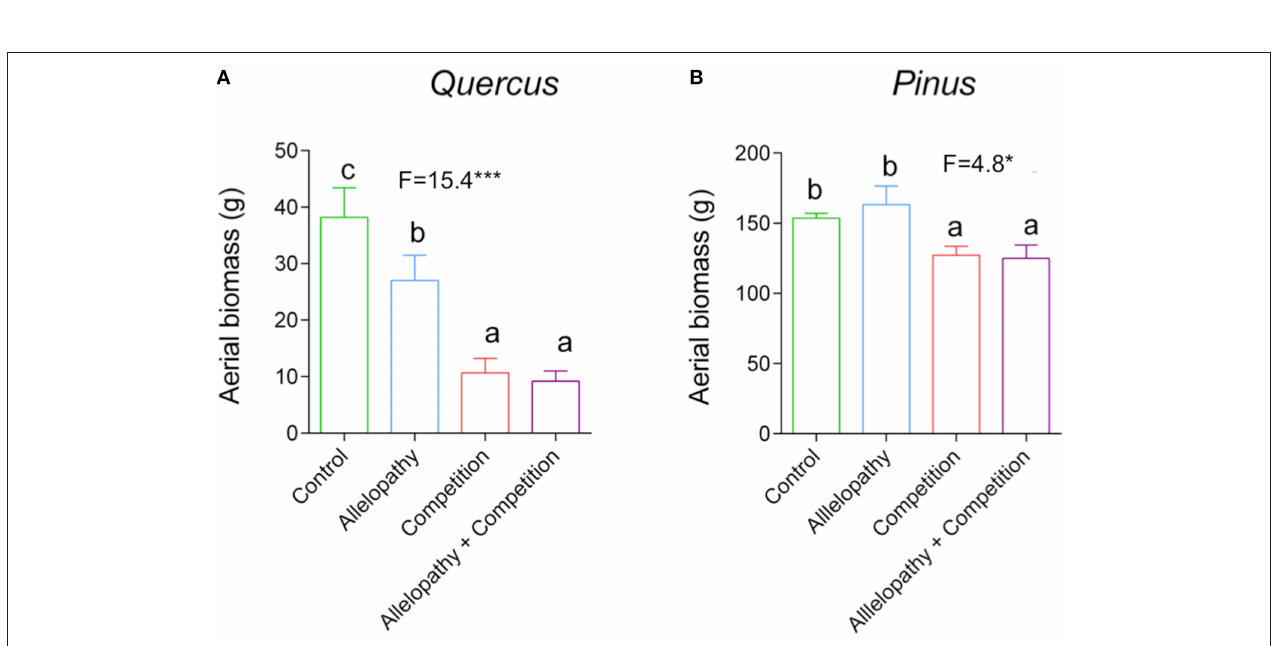
FIGURE 3 | Effects of interference treatment on aerial biomass of Pinus and Quercus . Height growth response in Quercus (A) and Pinus (B) in Control (green bars), Allelopathy (blue bars), Competition (red bars), and Allelopathy + Competition (purple bars) treatments. Bars are means ± SD (5 ≤ N ≤ 12). Different letters indicate a significant difference between